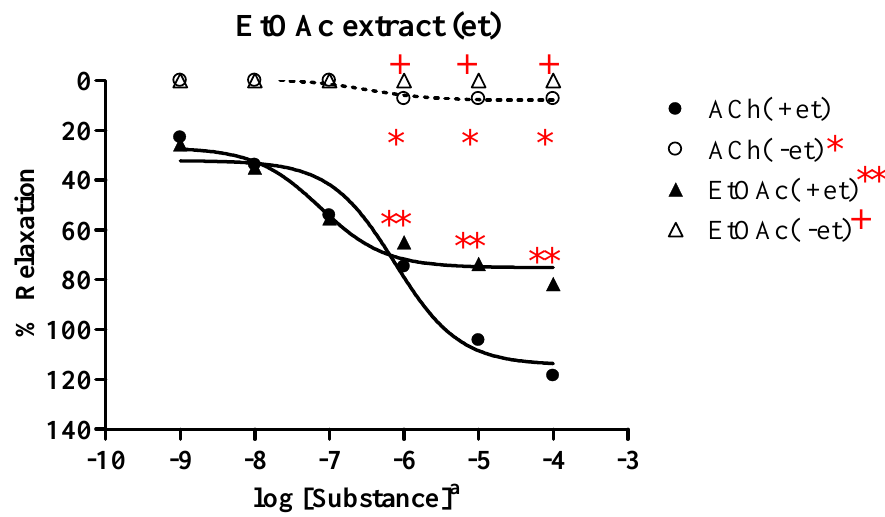
Figure 6. Effect of EtOAc extract and ACh on the vascular function of rat thoracic aorta under removal of endothelium (-et) compared with intact endothelium